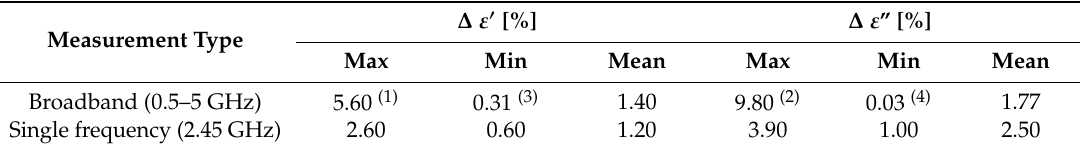
Table 2. Combined uncertainties in complex permittivity measurements performed on all materials with the Slim Form probe kit. ε′ and ε′′ are respectively the real and imaginary parts of the permittivity.